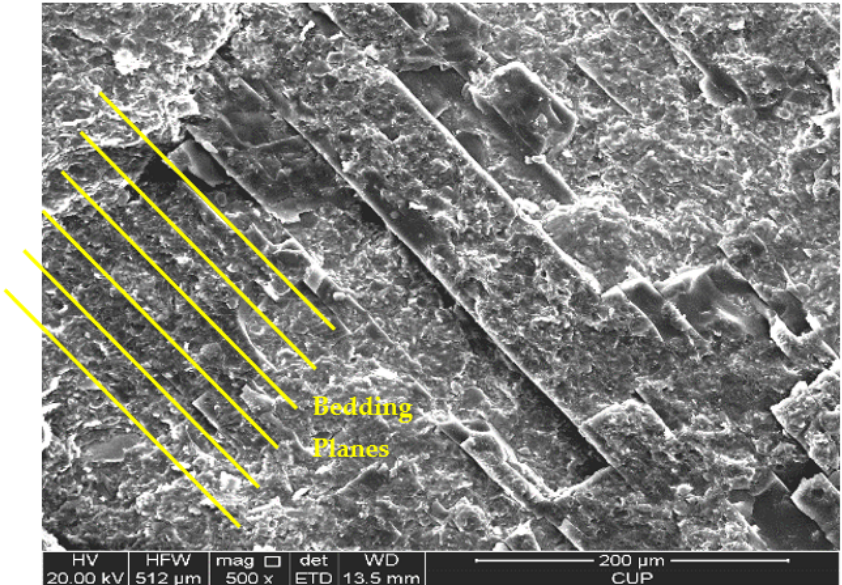
Figure 2. SEM image of a shale sample from Longmaxi formation.